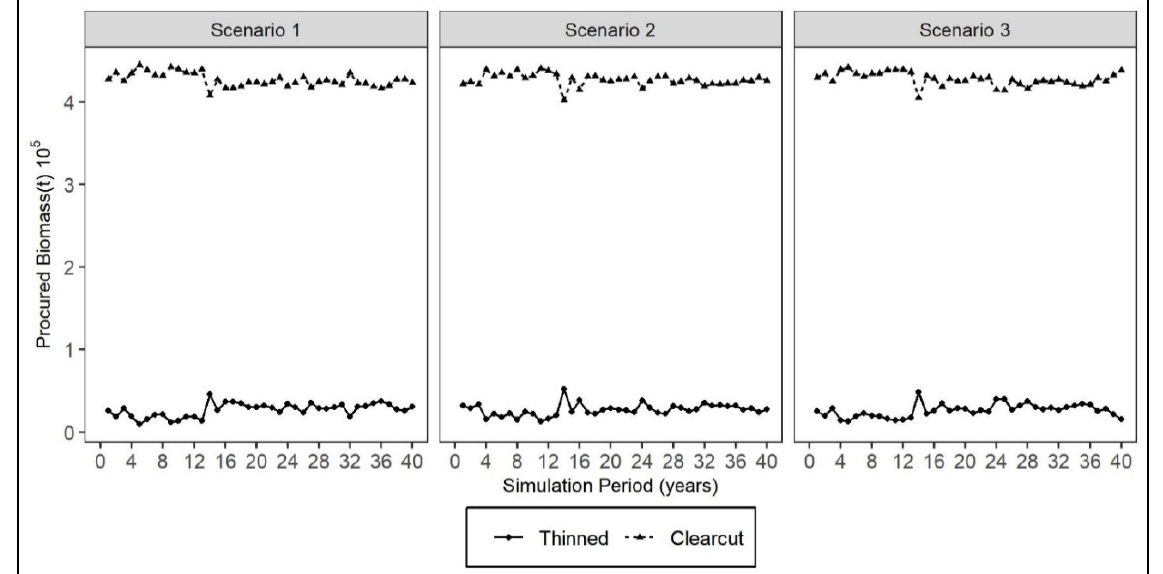
Figure 6. Distribution of total pulpwood sourced from thinned and clearcut stands over the simulation period. Scenarios 1, 2 and 3 are differentiated in Table 1.